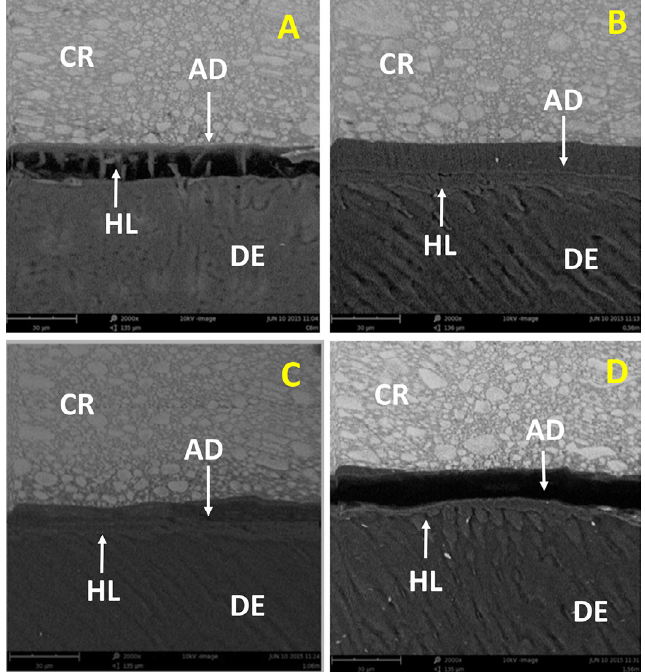
Figure 3- Photomicrographs of the bonding interface between dentin (DE) and composite resin (CR) after 6 months of storage: A) Control group; B) EGCG 0.5 wt%; C) EGCG 1.0 wt%; D) EGCG 1.5 wt%. AD=adhesive; HL=hybrid